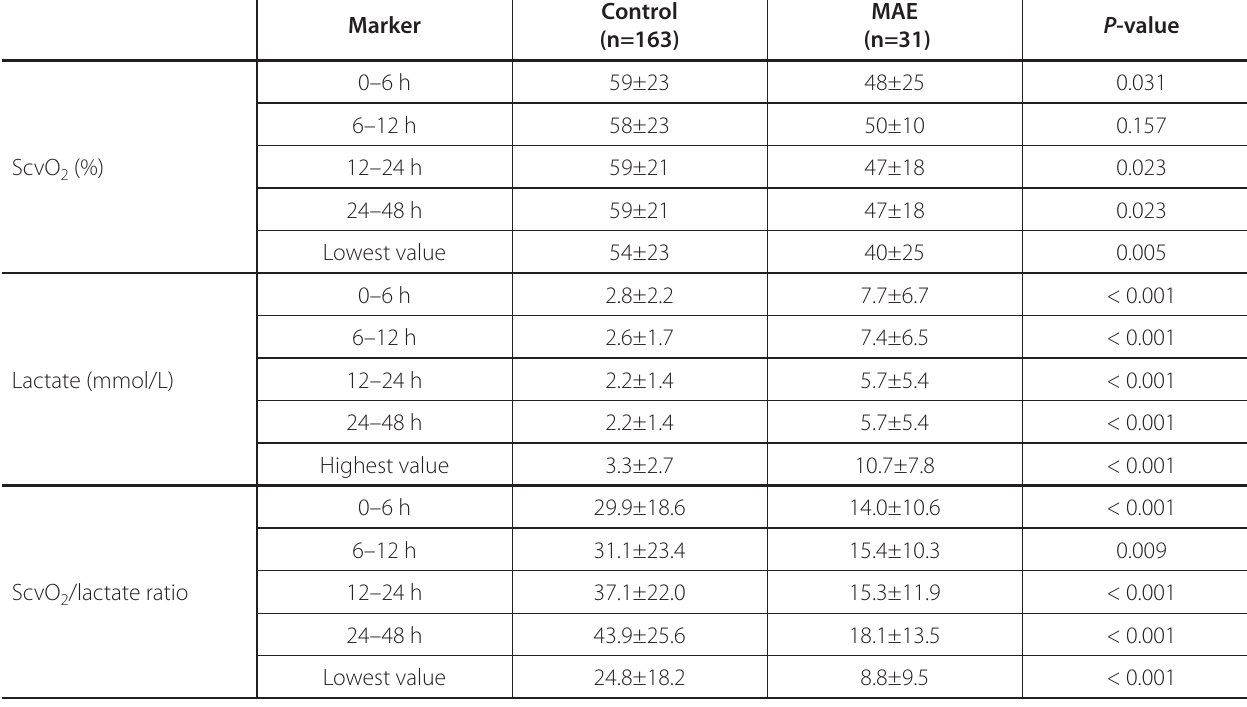
Table 4. Values of postoperative arterial lactate, central venous oxygen saturation (ScvO occurrence of a major adverse event (MAE) within 48 hours after